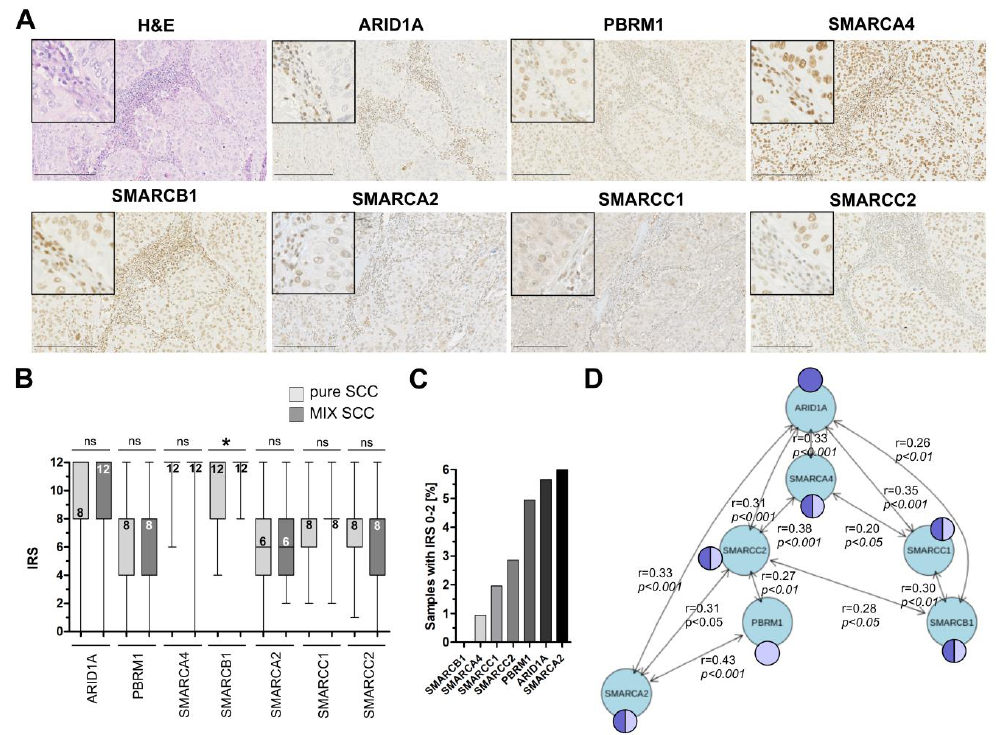
Figure 2. Protein expression of subunits of the SWI / SNF complexes BAF and PBAF in squamous-di ff erentiated bladder cancers (sq-BLCA). ( A ) H&E and immunohistochemical staining of seven subunits of the SWI / SNF complex are shown for a representative tissue core with ARID1A mutation (c.4005-2A > G, p.(?)). Black scale bar: 100 µ M. For further immunohistochemical ARID1A staining according to the range of Immune Reactive Scores (IRSs) see Supplementary Figure S3. ( B ) Box plot graphs show overall distribution of IRS staining results of subunits for urothelial cancers with squamous components (MIX SCC) and pure squamous cancers (SCC). The numeric values correspond to the median value. ( C ) Frequencies of expression loss (IRS ≤ 2) shown for all analyzed subunits. ( D ) Expression network illustrating the statistical correlation between analyzed subunits of BAF and PBAF. Only significant ( p ≤ 0.05) spearman correlations (r-values as indicated) are shown. Dark blue: component of the BAF complex; light blue: component of the PBAF complex; * p < 0.05. PBRM1 (PBAF-specific complex) correlated with two PBAF-associated subunits. Contrary to that, ARID1A loss correlated with lack of expression of the BAF subunits SMARCA4 (Spearman r: 0.438, p ≤ 0.001), SMARCC1 (Spearman r: 0.492, p ≤ 0.001) and SMARCC2 (Spearman r: 0.296, p ≤ 0.01). No correlation was found between ARID1A and PBRM1, SMARCA2 or SMARCB1. Table 2. Loss of SWI/SNF proteins in squamous bladder cancer.